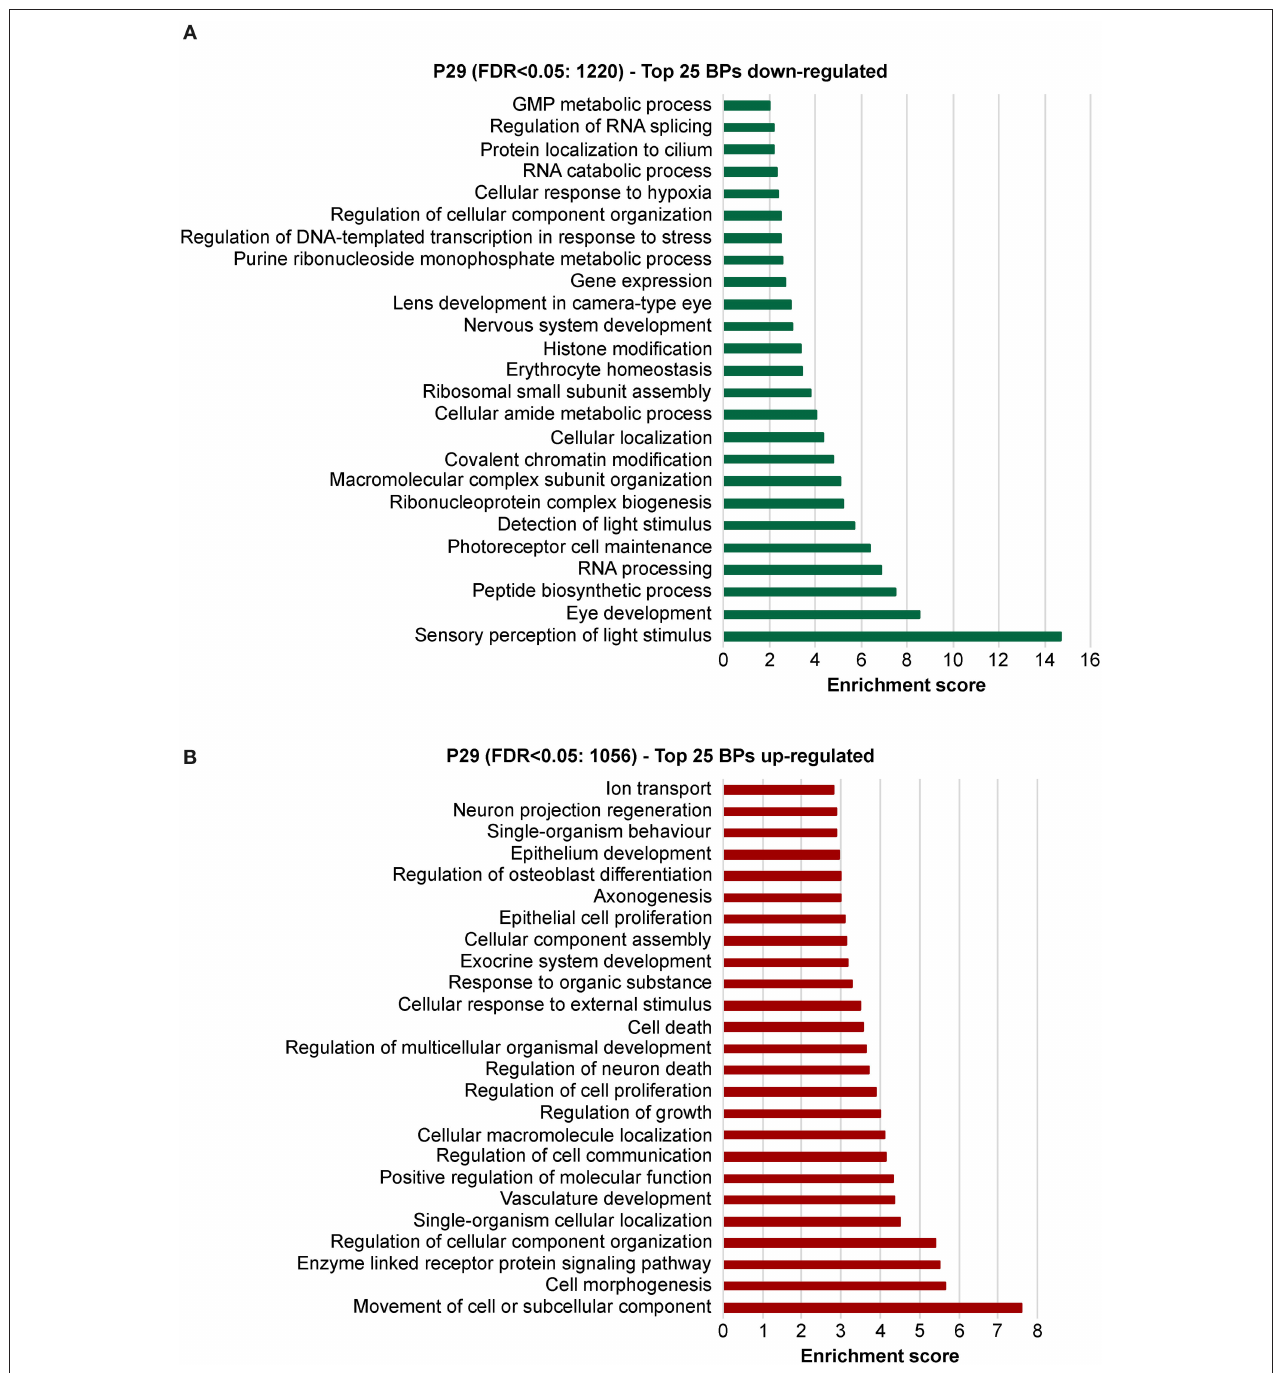
FIGURE 3 | Identification of the biological processes underlying the effect of deletion of Bbs8 at P29 via gene ontology analysis. Top 25 significant Biological pathways (BPs) among the inhibited transcripts (A) and the induced (B) in Bbs8 − / − vs. Bbs8 + / + are plotted. The Enrichment score for each BP cluster is plotted on the x-axis.